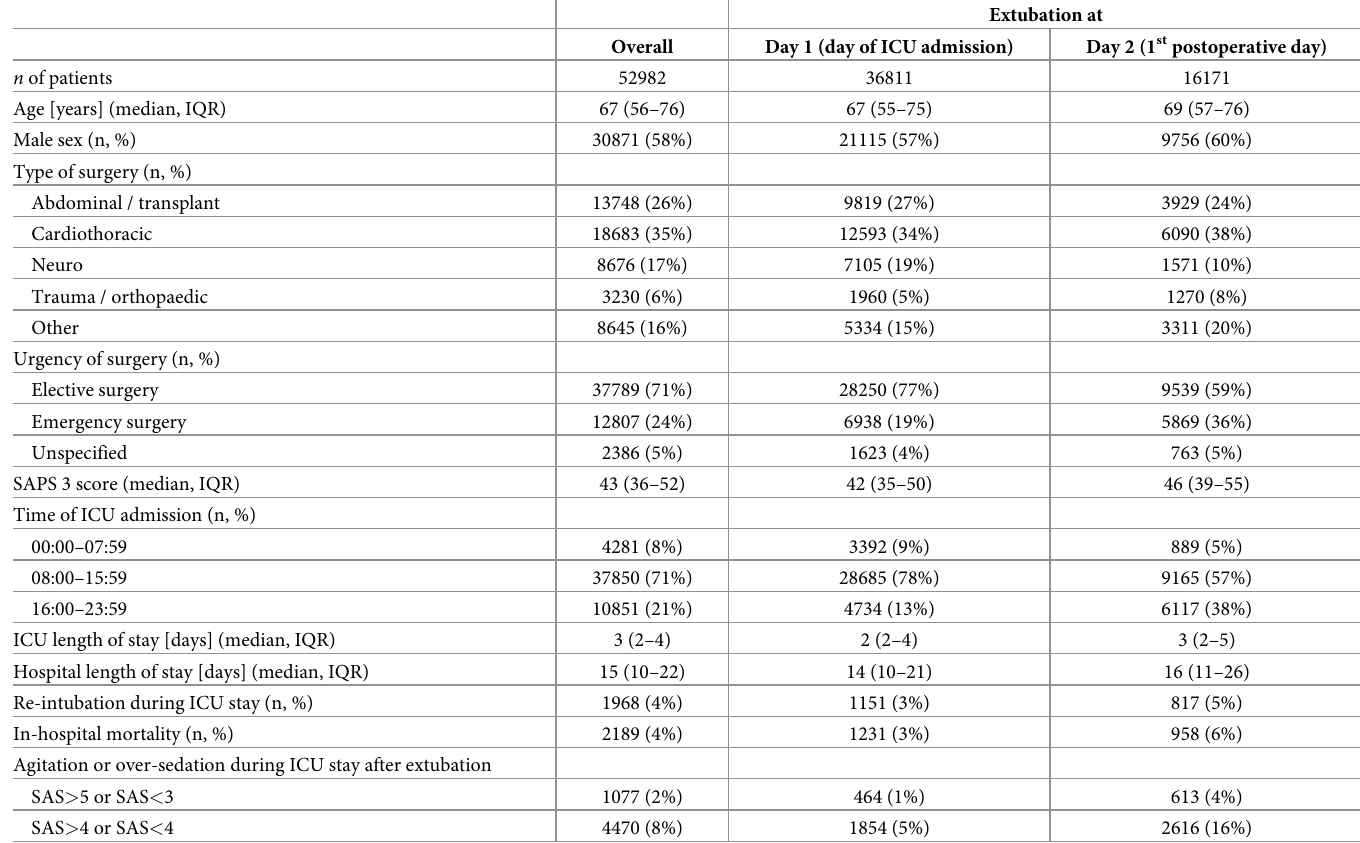
Table 1. Baseline patient characteristics, characteristics of surgery, and outcomes in the main patient